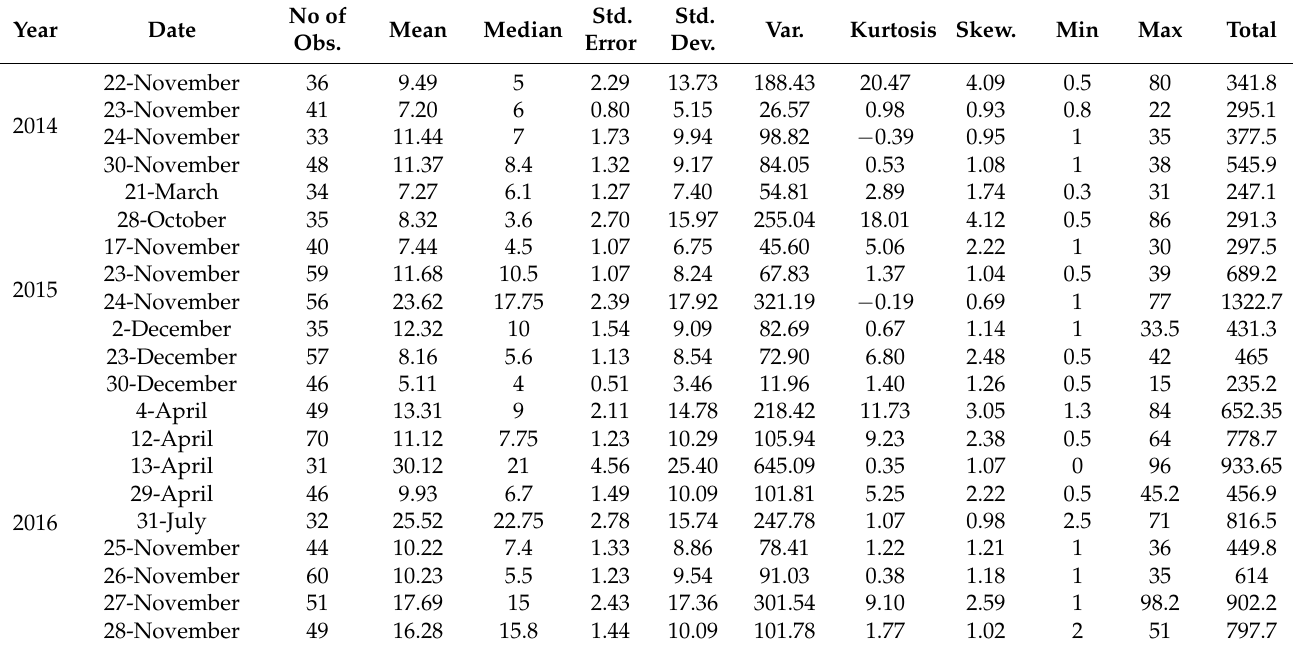
Table A1. Descriptive statistics of large rainfall events over Saudi Arabia observed from 2014 to